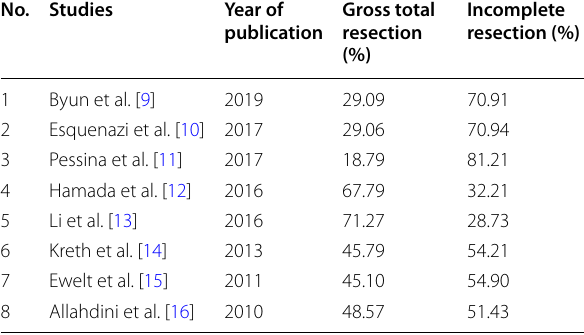
Table 3 Extent of resection